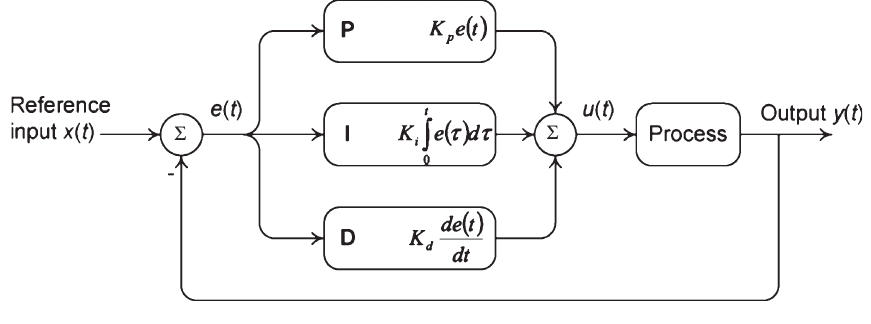
Fig. 3. PID controller